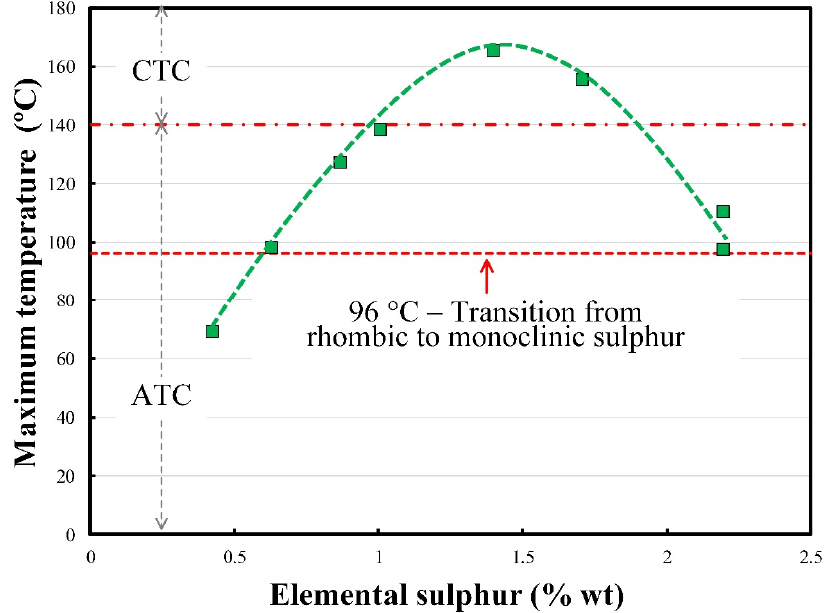
Figure 10. Elemental sulphur and transition from Stage A to Stage B: RMD sample.